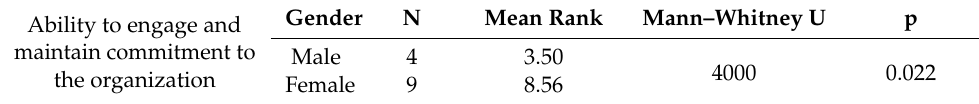
Table 5. The evaluation of teleworking between Baby Boomers men and women.